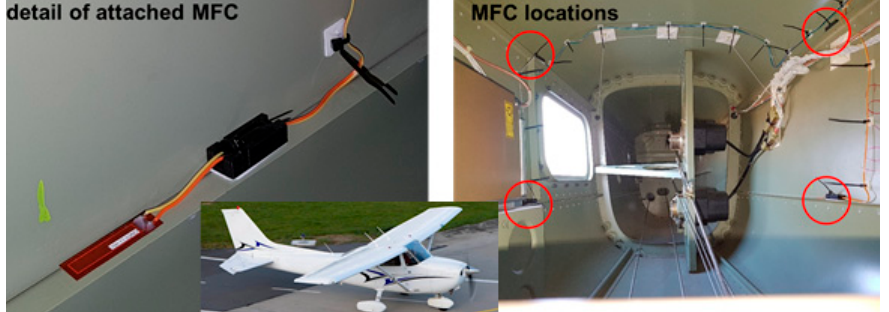
Figure 17. MFC patches embedded into the structure of a small civil aircraft [29]–reprinted by permission from Elsevier.